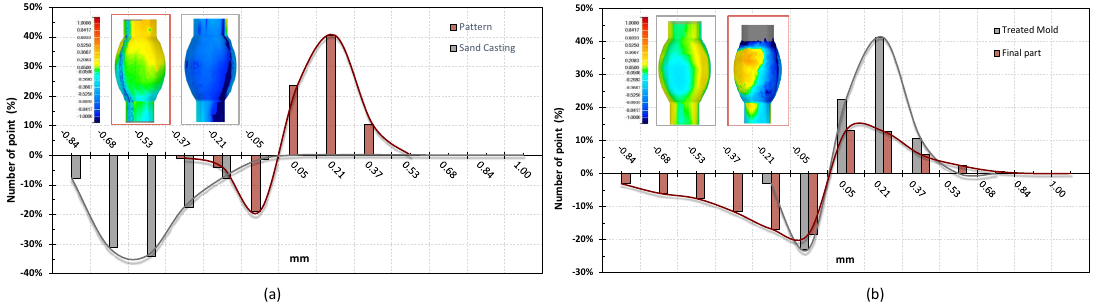
Figure 12. Dimensional deviation with respect to CAD: ( a ) sand casting technique, ( b ) 3DP technique. Table 6. Upper and lower deviations for both